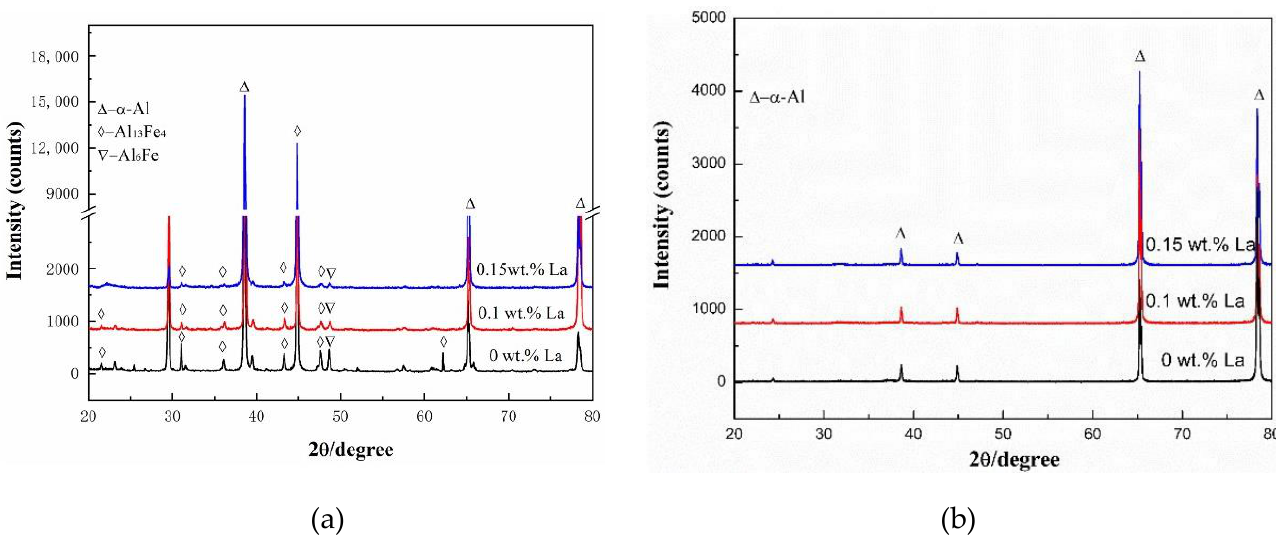
Figure 4. XRD patterns of the alloys: ( a ) as-homogenized ingot; ( b ) heat-treated foil. Figure 5a–c present SEM images of Al-0.2Fe-0.06Cu alloys with different La addition after heat treatment at 120 ◦ C for 10 h. The polished surface was parallel to the rolling direction. There were many micrometer-sized particles dispersed in the Al matrix in the three alloys and their shapes were various, including rod-shaped bars, quadrangles, ellip- soids and irregular shapes. It could be determined through the energy X-ray spectrometer (EDS) patterns (Figure 5d,e) that the particles indicated by the arrow and cross marks in Figure 5a–c were AlFe and AlFeLa phases, respectively. Combined with the testing results of the XRD diffraction pattern (Figure 4), it could be further determined that the AlFe particles were Al 13 Fe 4 and Al 6 Fe [19–21]. The morphology of particles with different compositions was also different. Most of the AlFe phases had a rod-shape and the size was relatively large. The AlFeLa phases were ellipsoidal and smaller. Compared to the La-free alloy (Figure 5a, Al-0.2Fe-0.06Cu), the AlFeLa phase appeared in the La-containing alloy (Figure 5b, Al-0.2Fe-0.06Cu-0.1La) and the number of AlFe particles was significantly reduced with a smaller size. As the La content increased to 0.15wt.% (Figure 5c, Al-0.2Fe- 0.06Cu-0.15La), it was simultaneously observed that the number of AlFeLa phase began to increase. The quantity of AlFe particles was further reduced. With the addition of La, the size of the Al 3 Fe phase decreased as the rare earth La had strong chemical properties and was easy to gather around the second phase